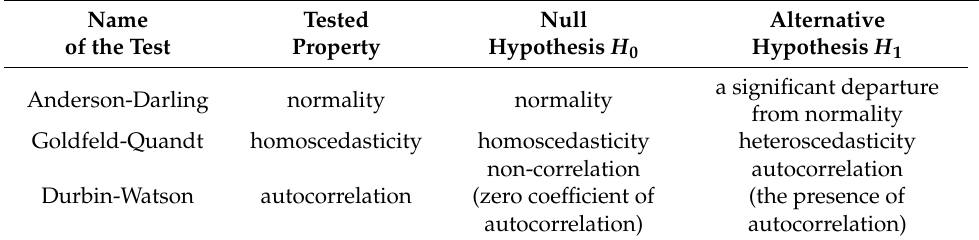
Table 3. Basic data of the three test procedures applied.